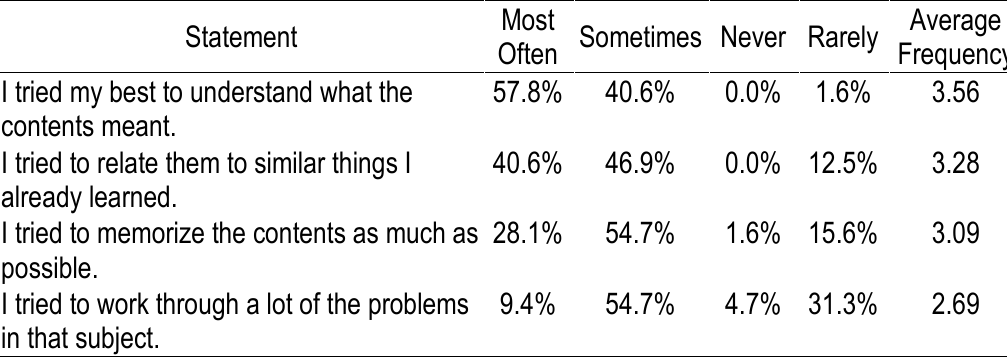
Table 5. Study methods used by the students